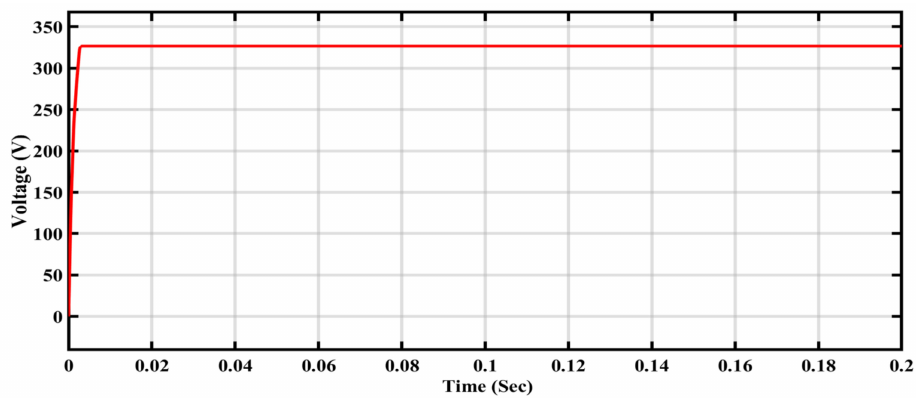
Figure 8. Total dc-link voltage of the three PV sources.